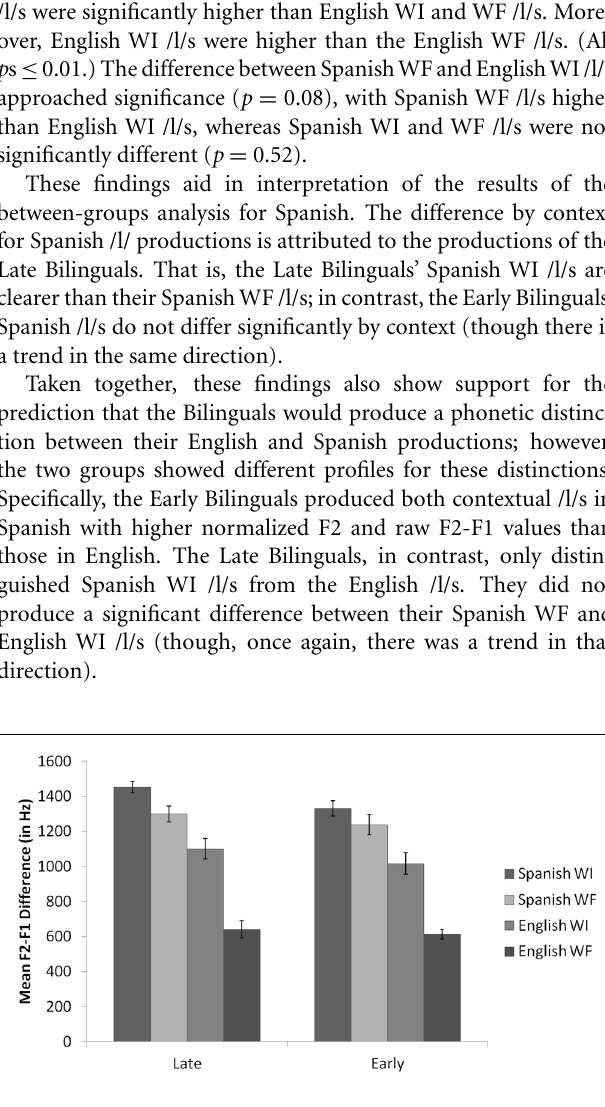
FIGURE 5 | Mean normalized F2 values by language and context for Late Bilinguals and Early Bilinguals. Error bars refer to standard errors.